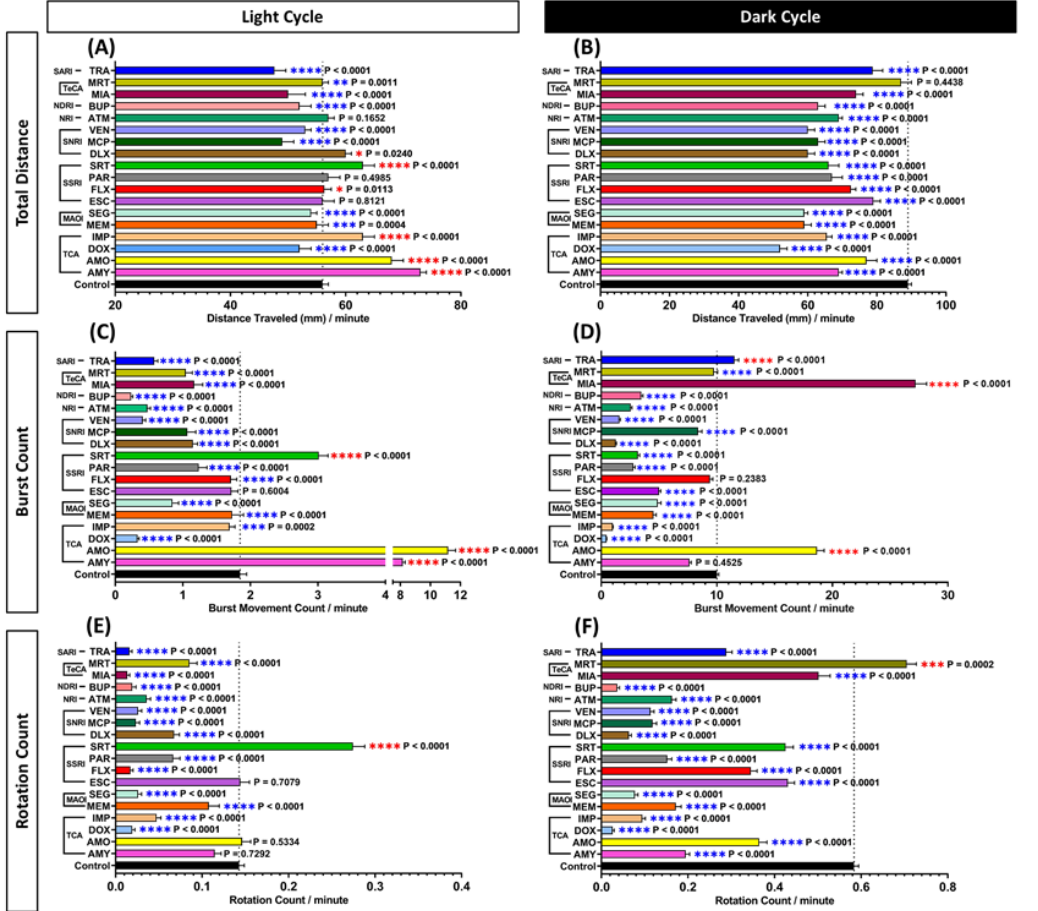
Figure 2. Comparison of ( A , B ) total distance traveled, ( C , D ) average burst movement, and ( E , F ) rotation count of zebrafish larvae in light and dark cycles, respectively. The statistical significance was tested by Mann–Whitney test. Every treated group was statistically compared to the control group individually. Data are presented as median with 95% CI for ( A , B ), and as mean with SEM for ( C – F ). Blue asterisk indicates a significant decrease in the value and red asterisk indicates a significant increase in the value in comparison to the control group ( n = 144 for control, n = 48 for each tested antidepressant; * p < 0.05, ** p < 0.01, *** p < 0.001, **** p < 0.0001). The details of these two-way ANOVA test results can be found in Table S1.